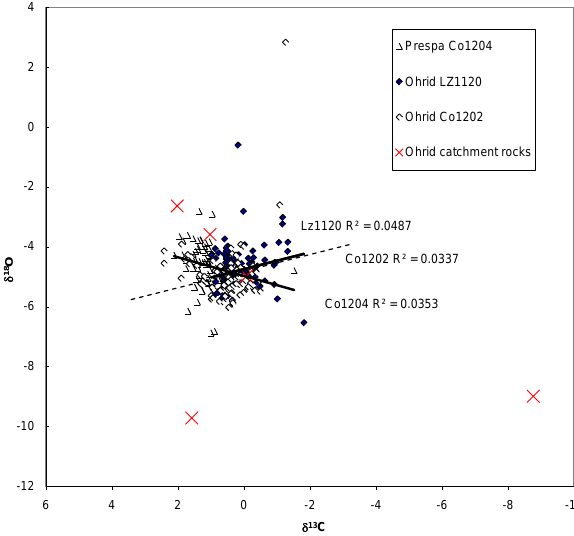
Fig. 6. δ 18 O vs. δ 13 C diagram of authigenic calcite (from Lakes Ohrid and Prespa) and samples of the carbonate catchment rocks surrounding Lake Ohrid. The low isotope values of some of the catchment rocks suggest that they have been post depositionally altered. There are no obvious mixing trends between the isotope composition of the authigenic calcite and the carbonate catchment rocks.